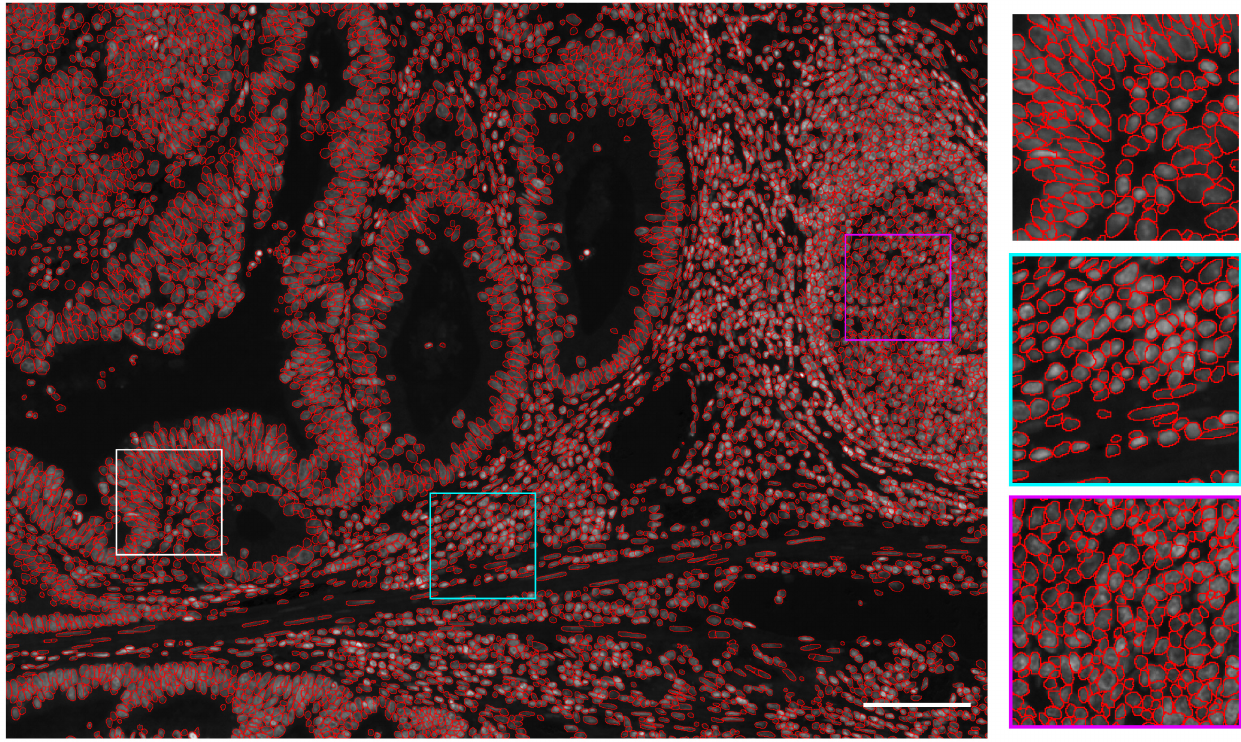
Figure 4. Nuclear segmentation example when combining U-Net and Mask R-CNN. Segmented nuclei obtained by combining U-Net and Mask R-CNN overlaid as red circles over the processed image. Zoomed-in regions are displayed on the right side with corresponding squared colors. Scale bar =